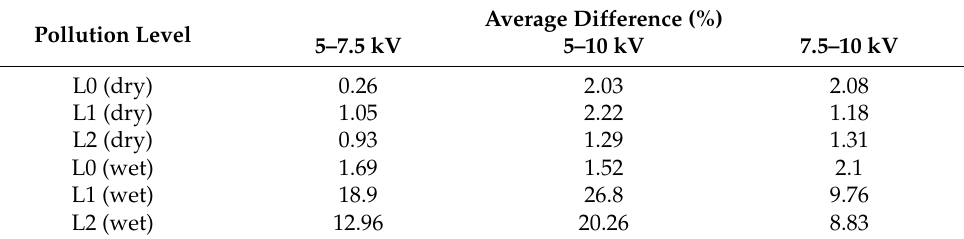
Table 3. Comparison of differences between voltage levels for dielectric loss